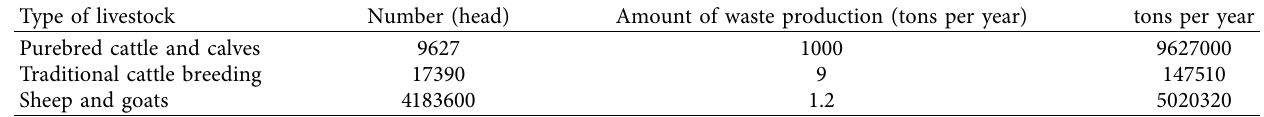
Table 1: The amount of daily production waste of each type of livestock in the Bile Savar.